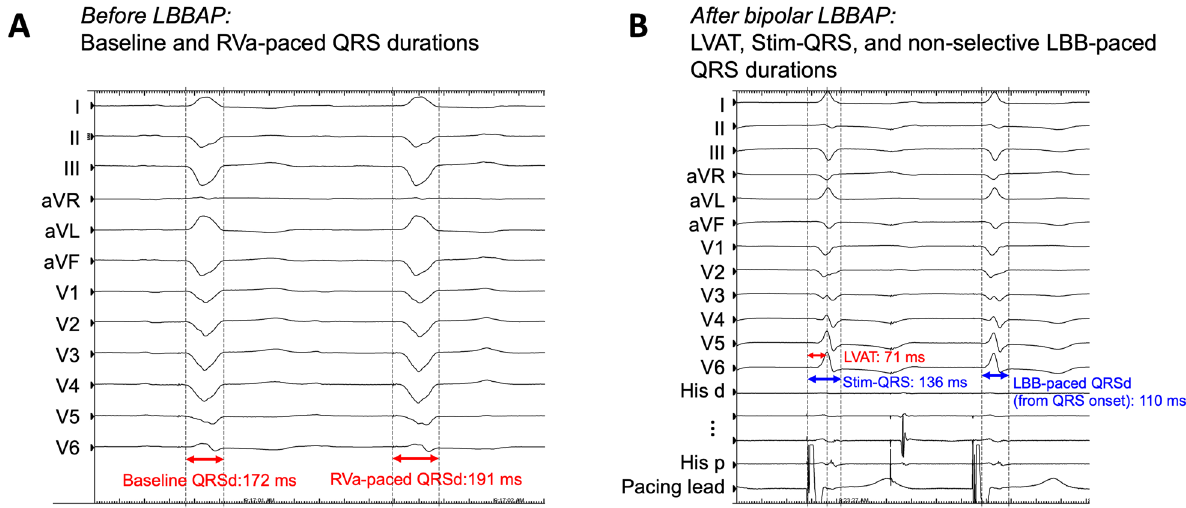
Fig. 3 Measurements during LBBAP. A Baseline and RVa‑paced QRS durations were 172 ms and 191 ms, respectively. B After bipolar LBBAP, LVAT was 71 ms, Bipolar stim to QRS duration was 136 ms, and LBB‑paced QRS duration was 110 ms. Non‑selective LBBAP was achieved. LBB left bundle branch, LBBAP left bundle branch area pacing, LVAT left ventricular activation time, RVa right ventricular